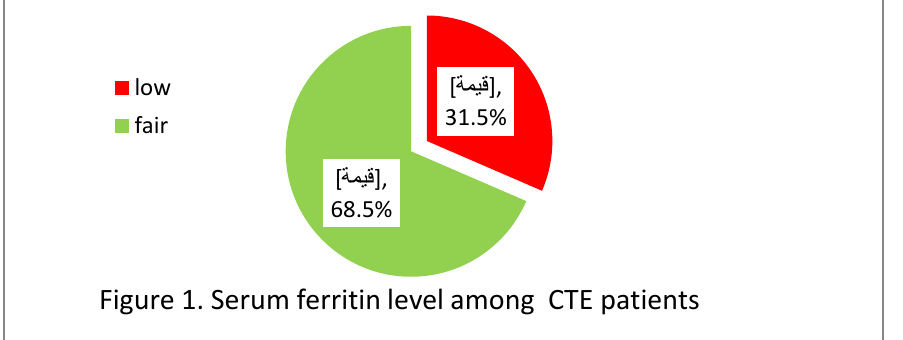
Figure 1. Serum ferritin level among CTE patients